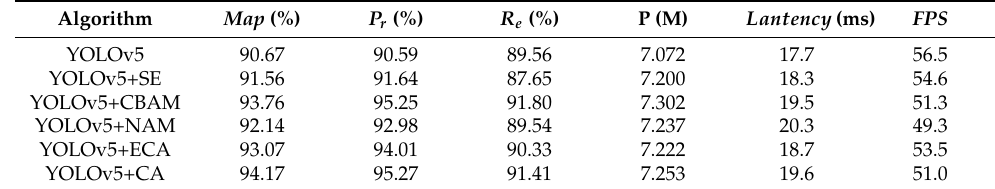
Table 2. The effects of different attention mechanism module on RSOD